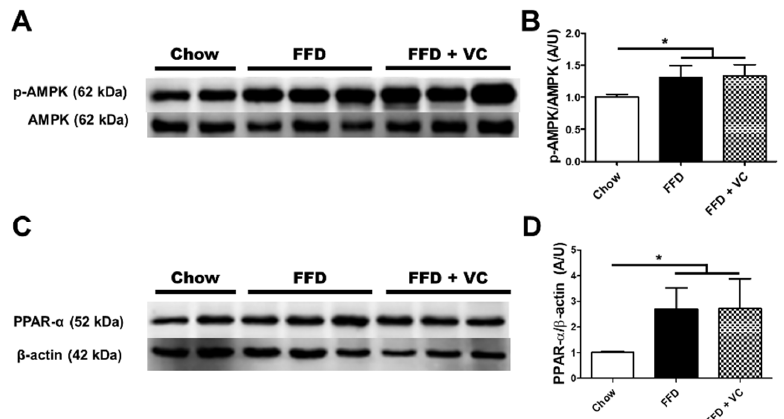
Figure 6. Effects of the mega-dose vitamin C treatment on catabolic pathways in whole liver tissue. ( A ) The protein expression of AMPK and phospho-AMPK; ( B ) Quantification data of AMPK phosphorylation; ( C ) The protein expression of PPAR- α and β -actin; ( D ) Quantification data of PPAR- α . Data are expressed as means ± SD per group ( B , D ). n = four to five mice in each group ( A – D ). * p < 0.05.